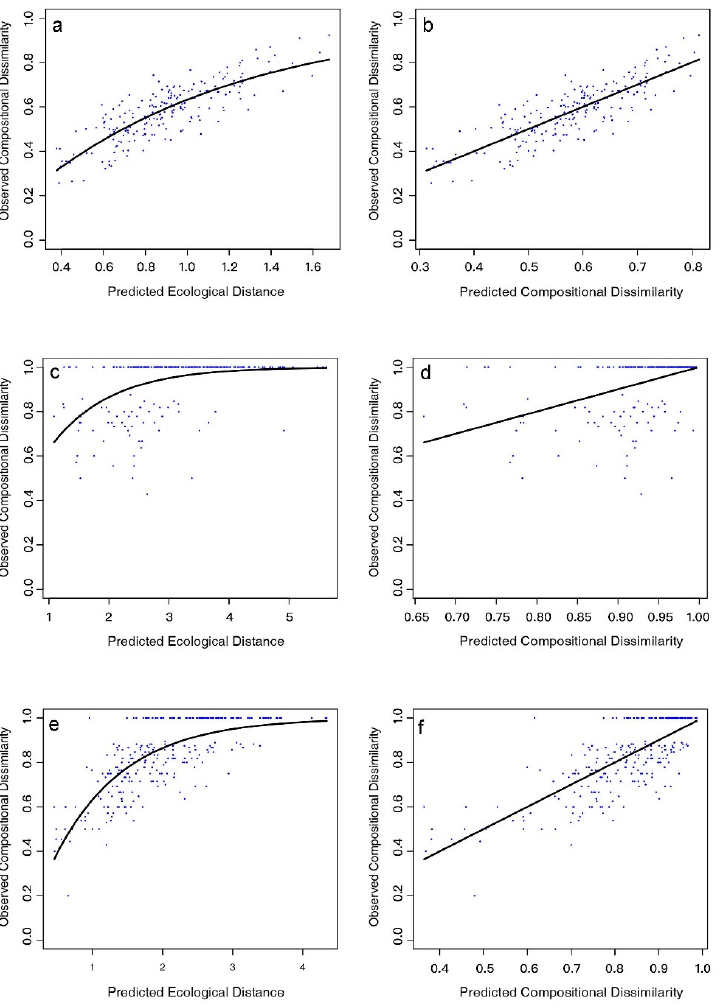
Figure 3. Relationships between compositional dissimilarity and geographical distance and rela- tionships between predicted species compositional dissimilarity and the observed species composi- tional dissimilarity of different life form plants (( a , b ) indicate trees, ( c , d ) indicate shrubs, ( e , f ) indi- cate